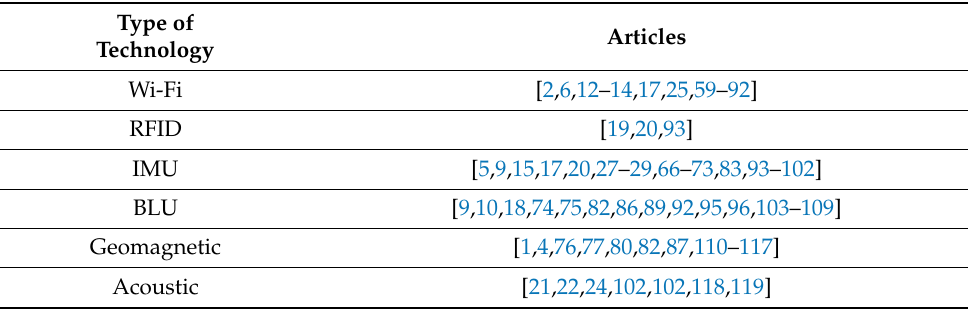
Table 1. Selected articles based on